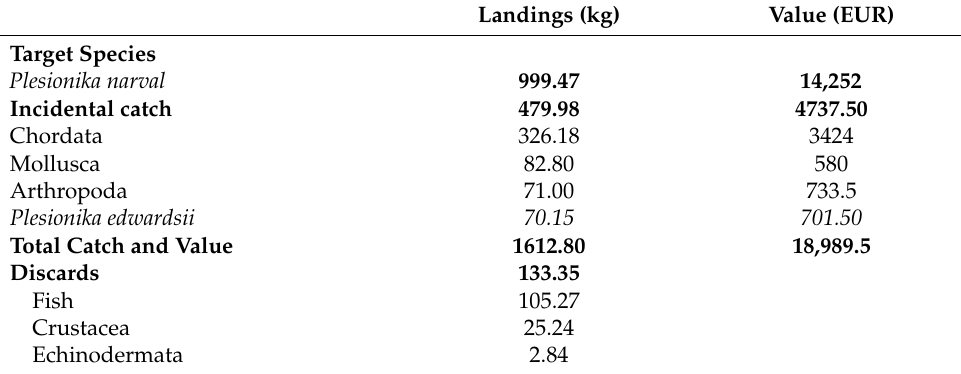
Table 1. Landings (kg) and value (EUR) of total catch (i.e., target species, incidental catch and discards) for a total effort of 8250 traps during an annual cycle in the small-scale shrimp-trap fishery of the southeastern Aegean Sea (eastern Mediterranean Sea).